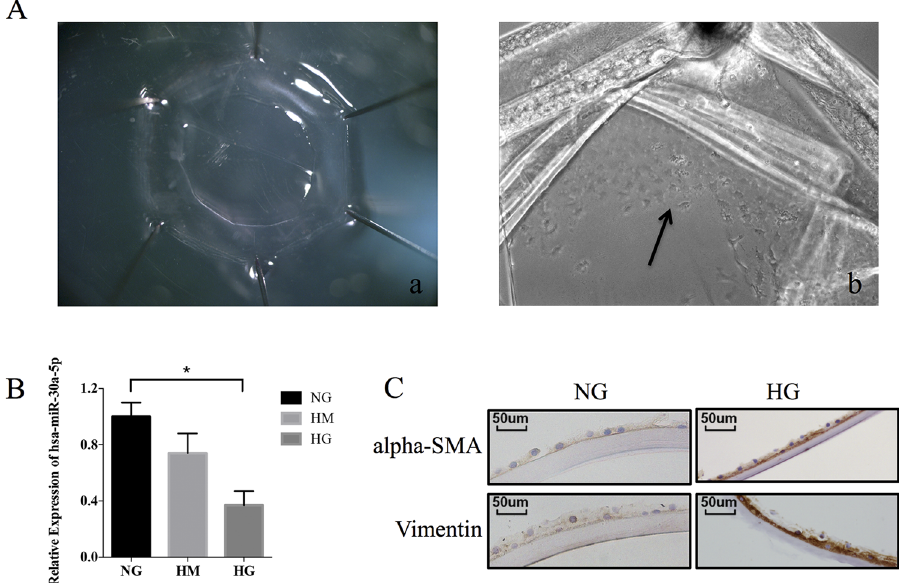
Figure 2. Human donor capsular bags as a diabetic cataract model in vitro . ( A ) Capsular bags were immersed in the culture medium: (a) immediately after pinning; (b) after 24 hours, when the LECs were observed to be migrating (arrow). ( B ) The expression of miR-30a-5p was detected by qRT-PCR. MiR-30a-5p increased in the presence of HG ( * P < 0.05, NG as control, N = 1), instead of HM (osmotic control). ( C ) Immunohistochemistry analysis was performed to detect the protein expression of EMT markers. The staining intensity of vimentin and alpha-SMA expression increased in HG compared to